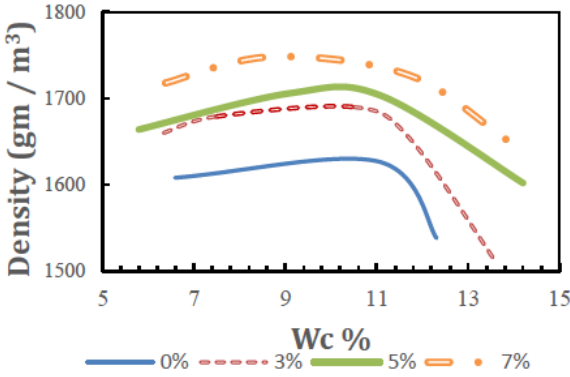
Figure 3: Effect of stabiliser percentage on moisture content and dry density